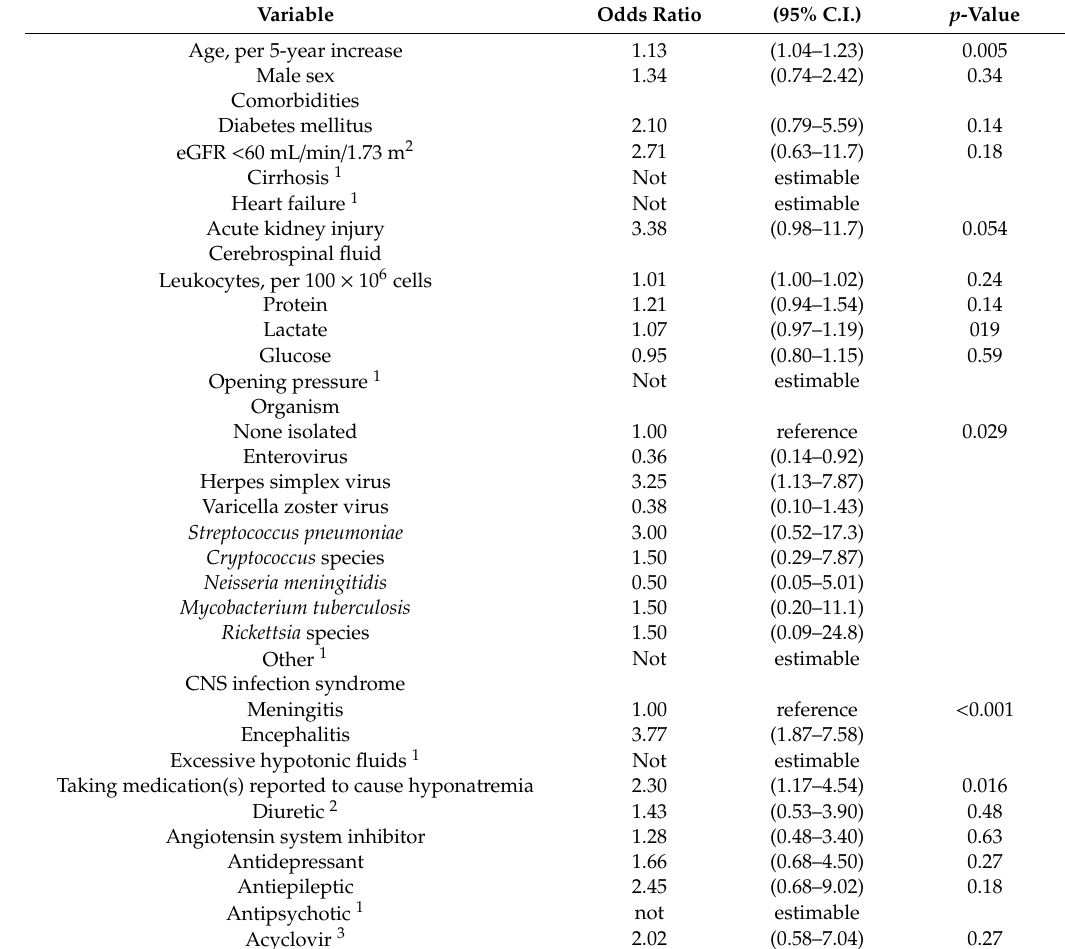
Table 5. Unadjusted logistic regression of